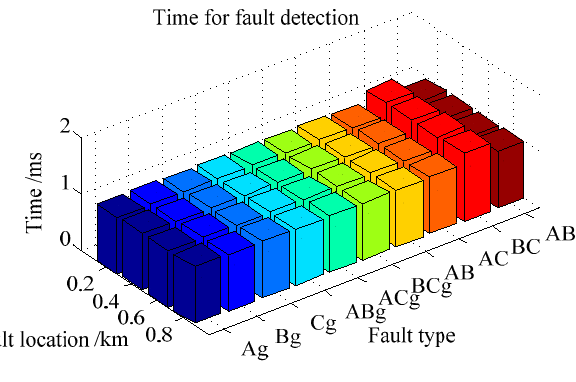
Figure 7. Simulation result of the double-ended power supply section.